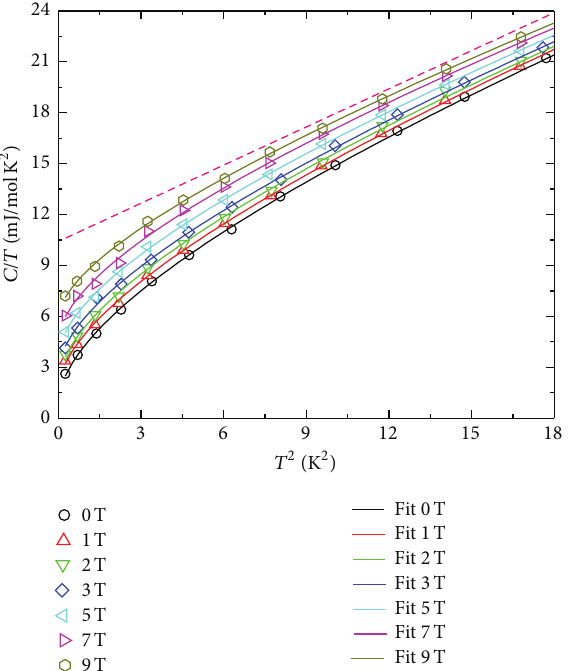
Figure3: Therawdata(coloronline)oftheSHunderdifferentfields in the low temperature region. The data are shown in 𝐶/𝑇 versus 𝑇 2 plot. The solid lines display the theoretical fitting (see text). The dashed straight line is the guide for the